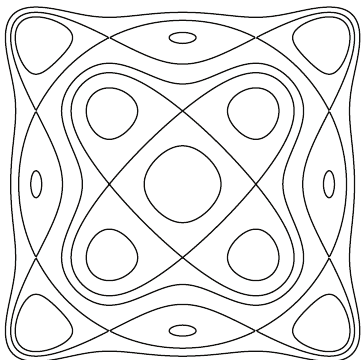
Figure 1: The phase portraits of (1) (𝜀=0)